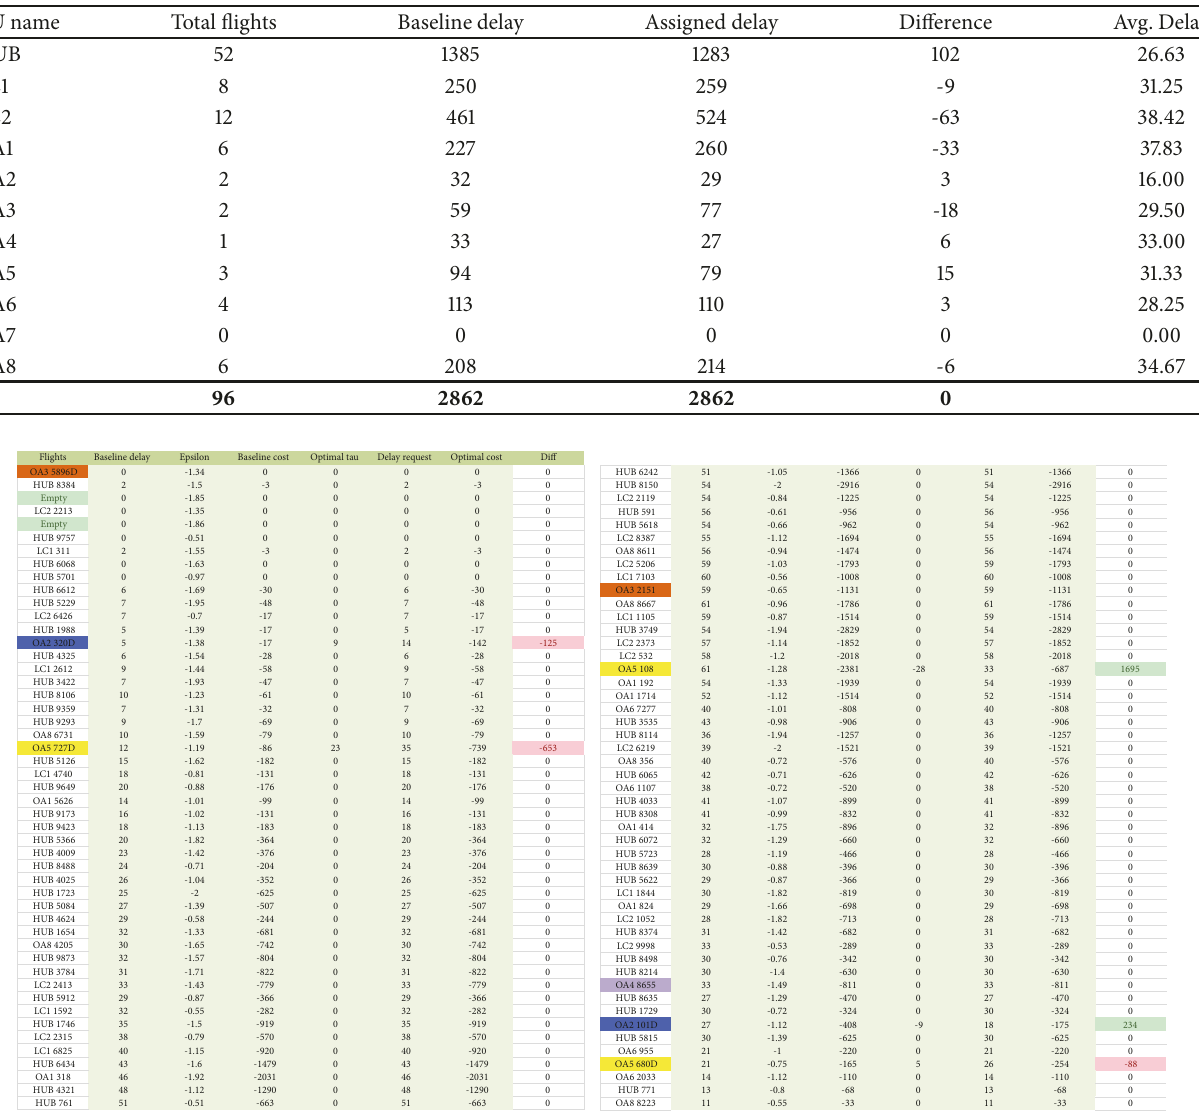
Table 5: Effect of sequence compression on the distribution of delay (case study 1).